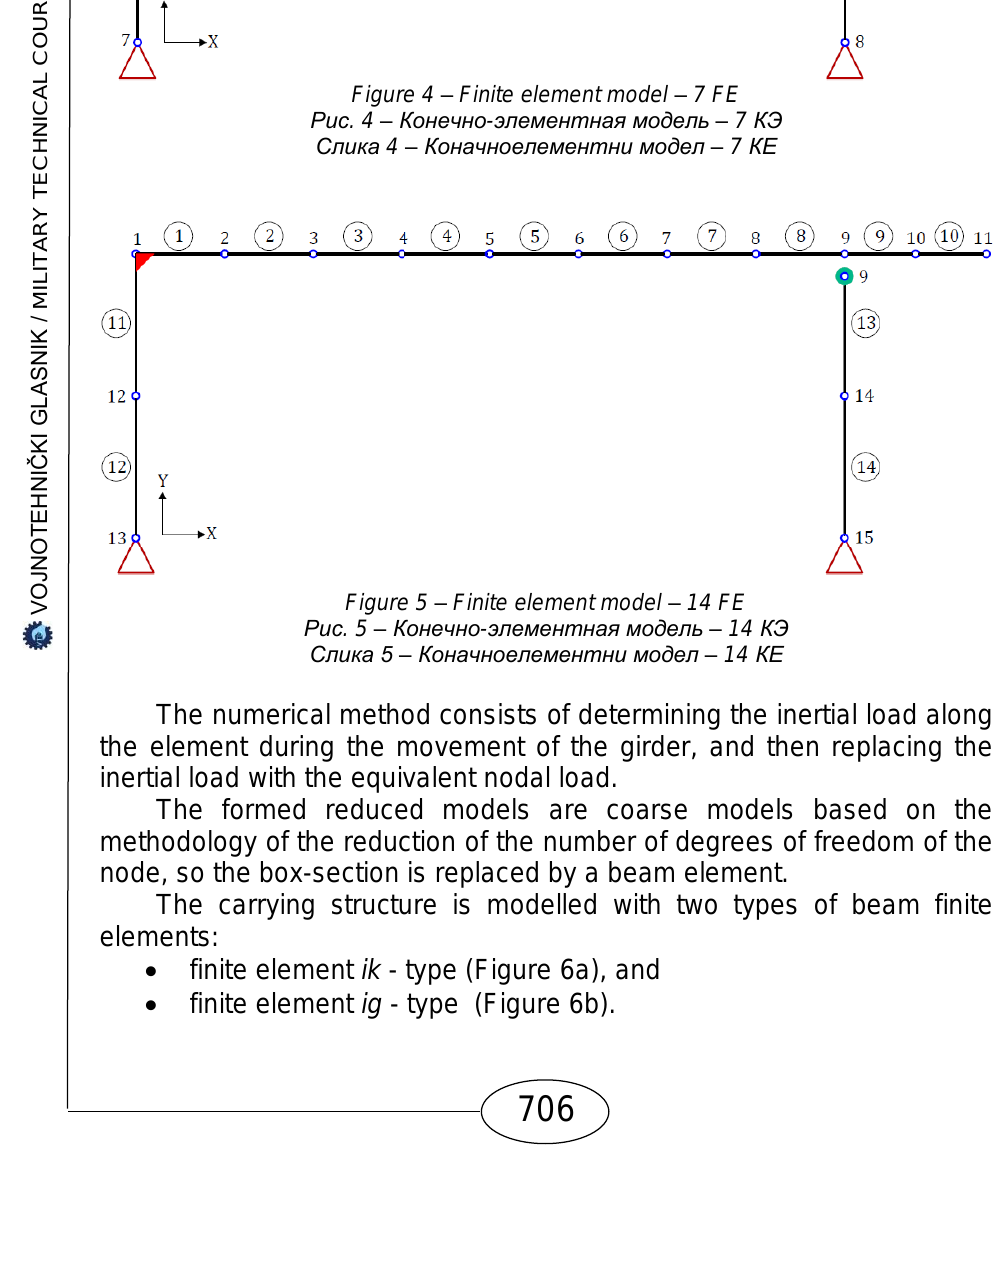
Figure 4 – Finite element model – 7 FE Рис. 4 – Конечно-элементная модель – 7 КЭ